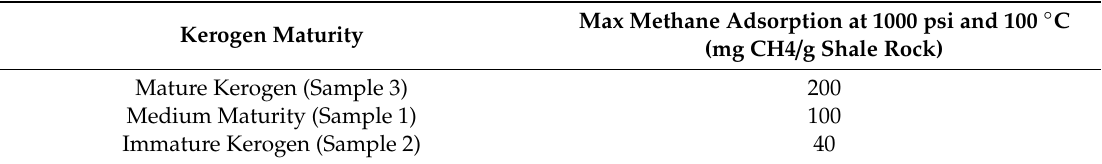
Table 5. Adsorption Capacity of the Actual Downhole Samples.